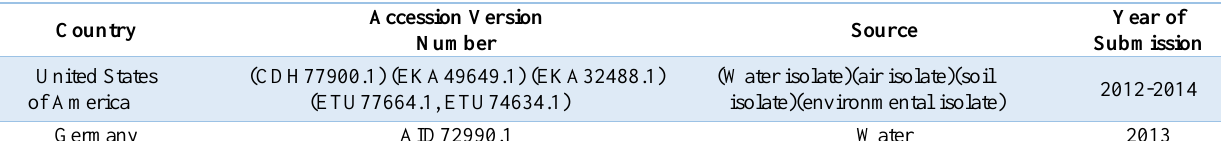
Table3 . Information about the Environmental Strains of Pseudomonas aeruginosa